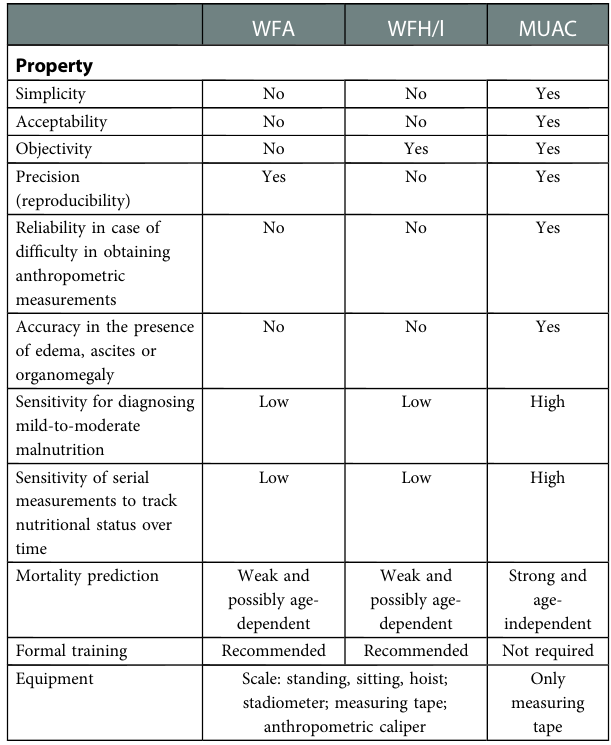
Scale: standing, sitting, hoist; stadiometer; measuring tape; anthropometric